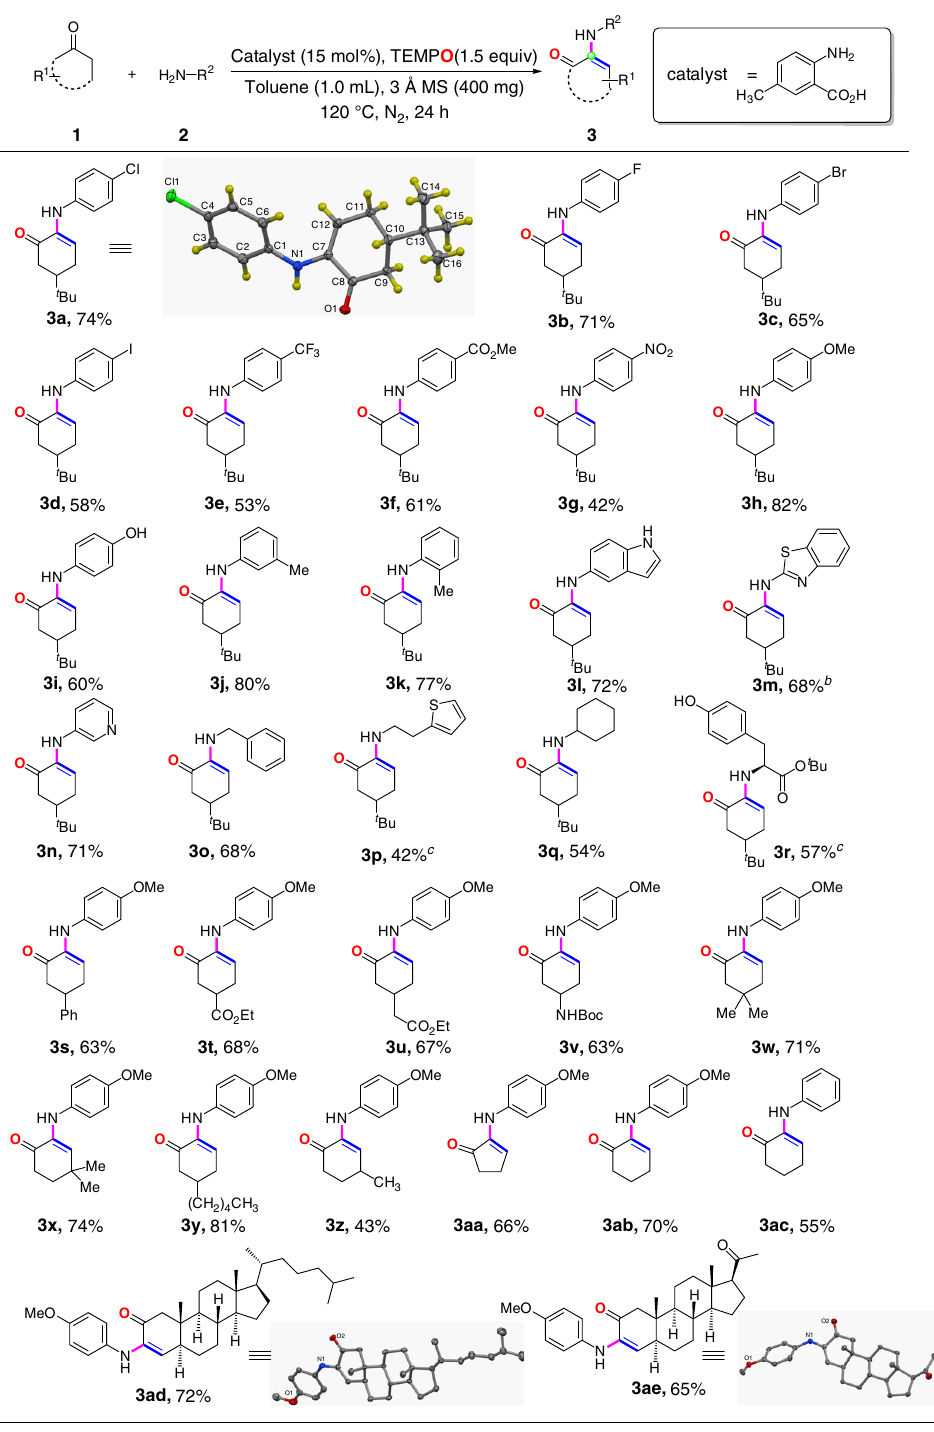
Fig. 3 Reaction of cyclic ketones with primary amines a . a Reaction conditions: 1 (0.3 mmol), 2 (0.2 mmol), catalyst (15 mol%), TEMPO (0.3 mmol), 3 Å MS (400 mg), toluene (1.0 mL), N 2 , 120 °C for 24 h. Isolated yields. b 1a (0.4 mmol), 2m (0.2 mmol), AlCl 3 (30 mol%), TEMPO (0.3 mmol), DCE (2.0 mL), N 2 , 120 °C for 24 h. c 1a (0.5 mmol) was the condensation of secondary imine with ketone. The con- ketone. Increasing the amount of TEMPO to 2.5 equivalents densation of primary amine with ketone catalyzed by anthranilic allowed the reaction of cyclohexanone with morpholine to acid involves the initial condensation of anthranilic acid with furnish aryl amine 7a in 62% yield in the absence of 4- ketone to form imine intermediate, followed by subsequent methylanthranilic acid (Fig. 4). Cyclohexanones bearing a variety reaction with primary amine to afford the fi nal imine product 31 , of functional group at 4-positions of their rings, such as, tert -butyl while relatively bulky secondary amine was dif fi cult to react ( 7c, 7d ), phenyl ( 7e ), ester ( 7h , 7i ) and amide groups ( 7j , 7k ) with the imine intermediate generated from anthranilic acid and reacted with morpholine or thiomorpholine and TEMPO to